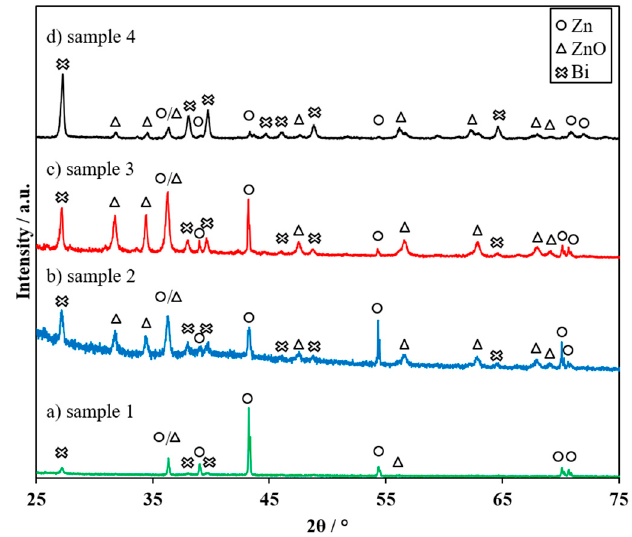
Figure 7. X-ray diffraction patterns taken after cycling of (a) sample 1 (1000 rpm, 15 min) (b) sample 2 (750 rpm, 30 min), (c) sample 3 (1000 rpm, 30 min), and (d) sample 4 (30 µ m, 1000 rpm, 30 min). The reflexes are assigned to Zn (ICDD-PDF-4-2018-00-004-0831), ZnO (ICDD-PDF-4-2018-01-070-8070) and rhombohedral Bi (ICDD-PDF-4-2018-01-071-4642).